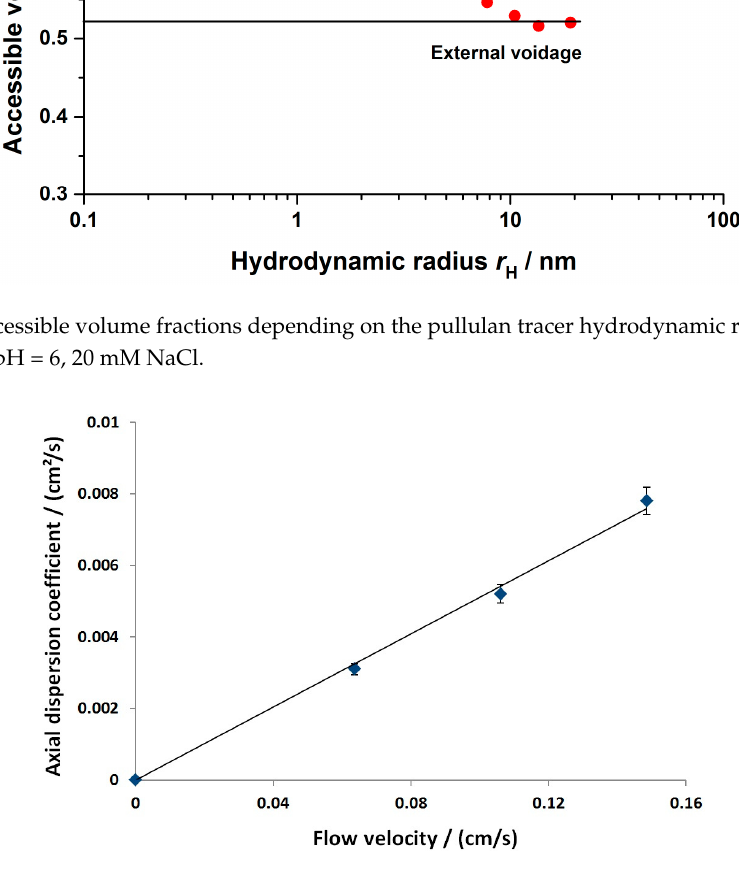
Figure 3. Accessible volume fractions depending on the pullulan tracer hydrodynamic radius. Buffer: 10 mM KPi, pH = 6, 20 mM NaCl.